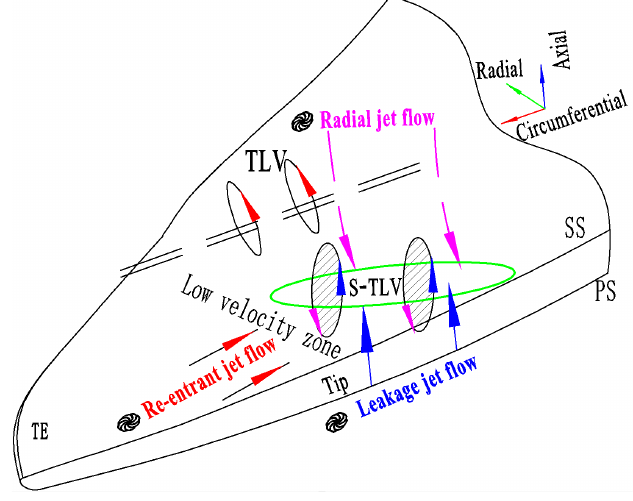
Figure 17. Schematic diagram of the S-TLV formation mechanism.